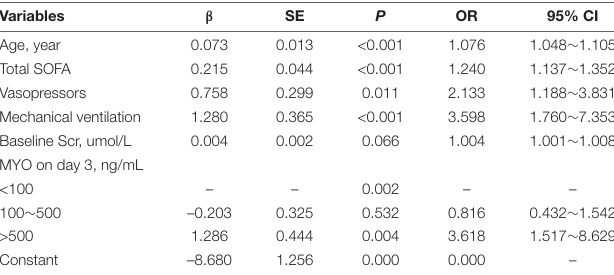
TABLE 3 | Regression coefficient estimates of the 1-year predictive model. Variables